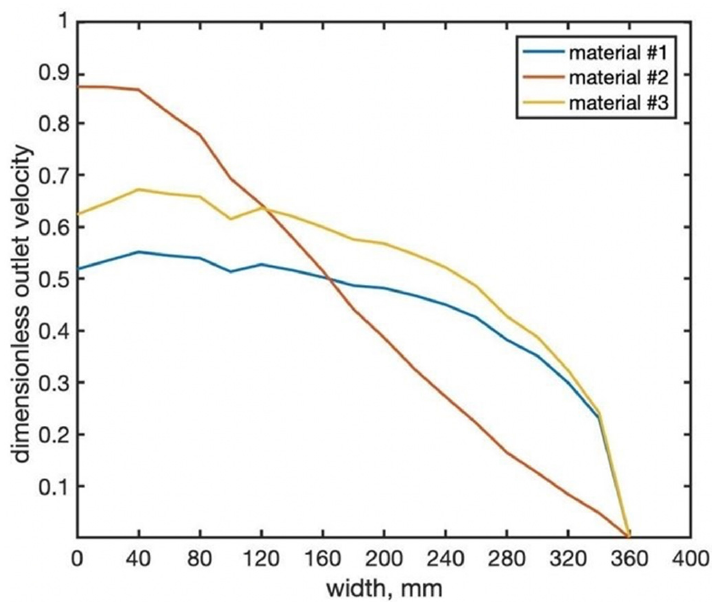
Figure 5. Outlet velocity distribution for three different extrusion materials.